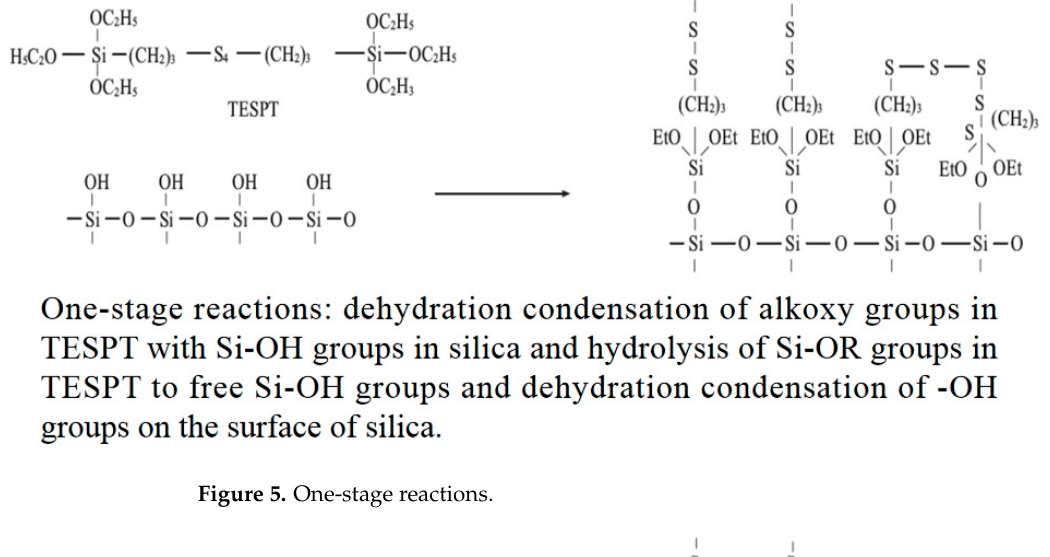
Figure 5. One-stage reactions.